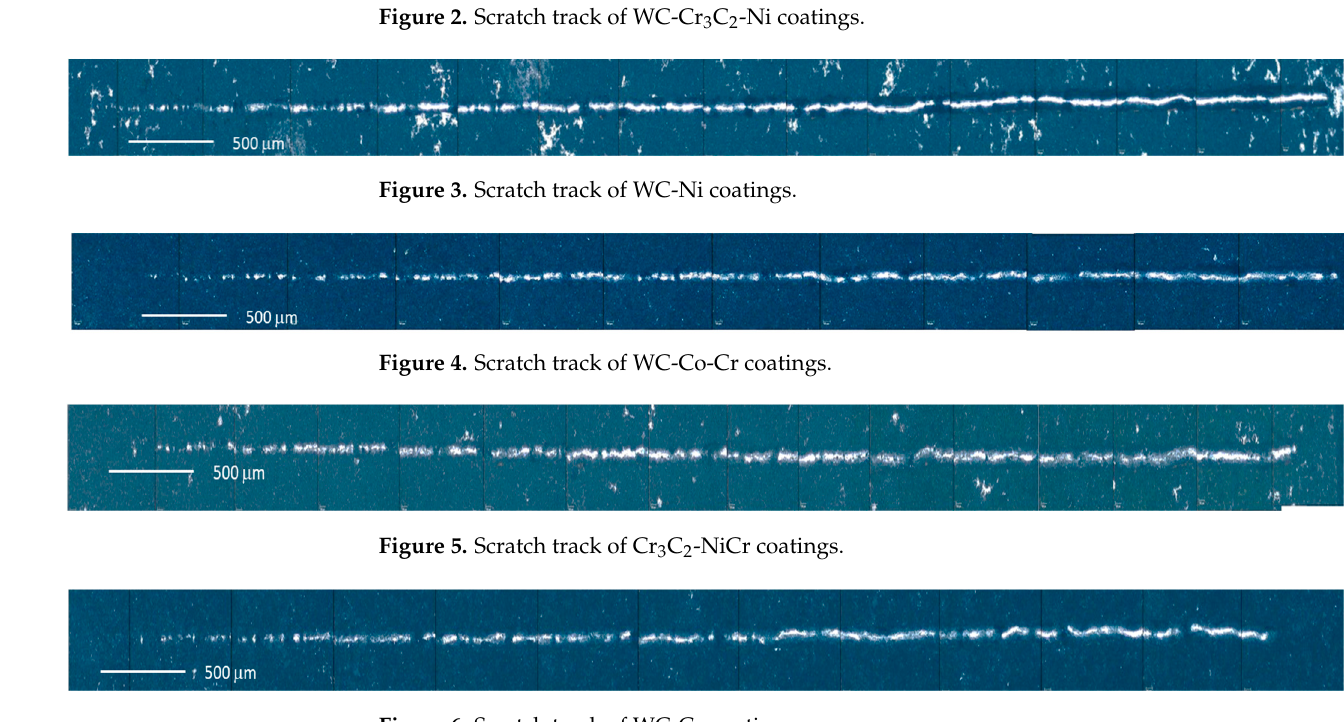
Figure 6. Scratch track of WC-Co coatings.